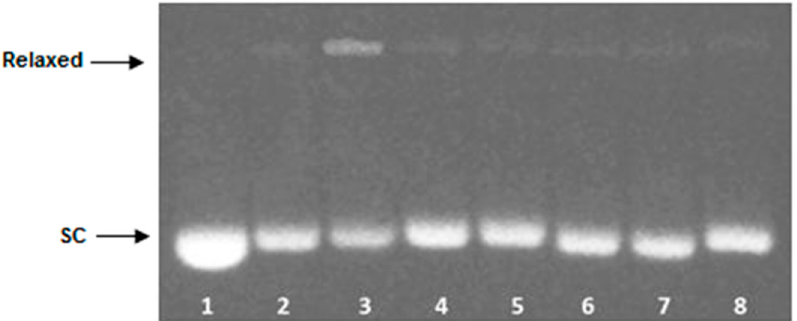
Figure 5. Influence of 2a on Topo II activity. The Topo II-mediated plasmid cleavage assay was carried out over constant enzyme concentration. Lane 1: supercoiled plasmid, SC; lane 2: plasmid with Topo II after 15 min of incubation time; lane 3: plasmid with Topo II and etoposide (50 µM) after 15 min of incubation time (positive control); lane 4–8: plasmid with Topo II and in the presence of compound 2a at the concentration of 5, 10, 15, 20, 30 µM, respectively.